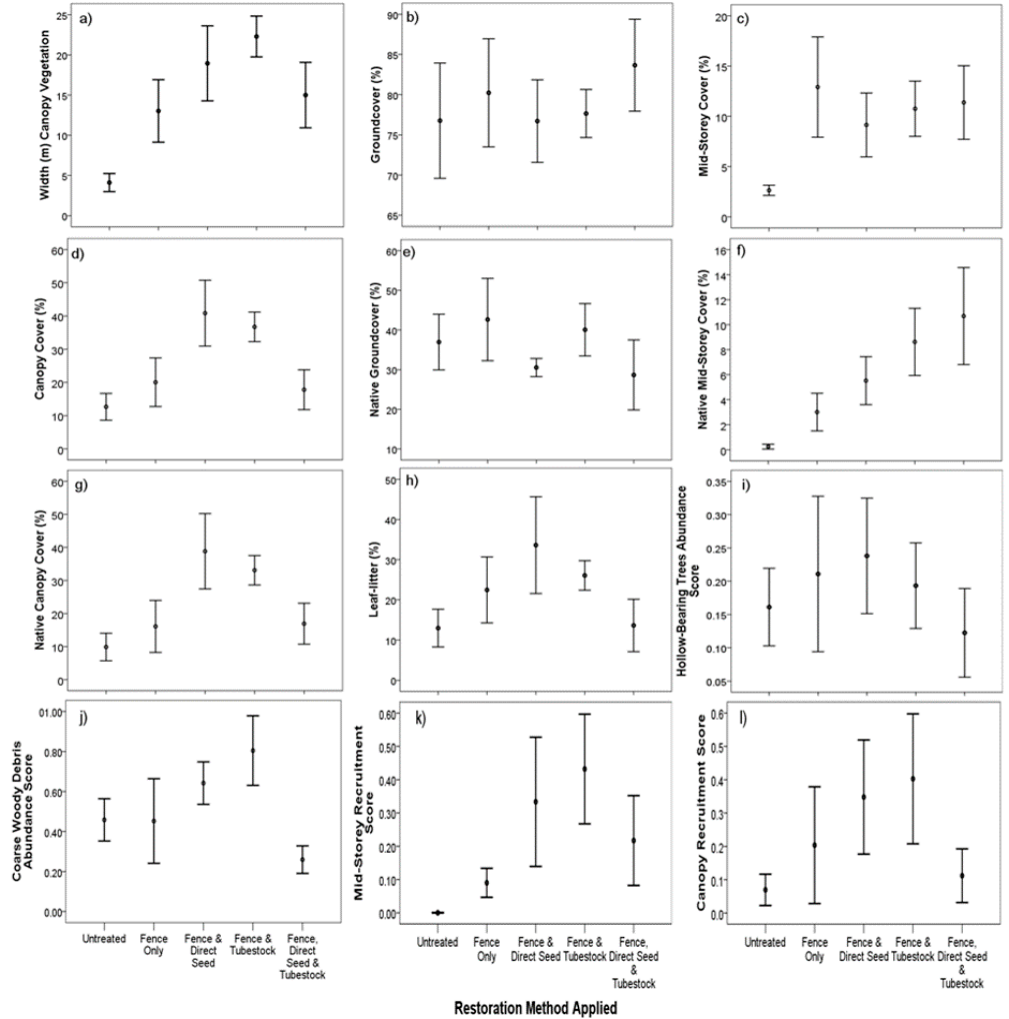
Figure 2. Mean riparian vegetation condition (RARC) scores 10 years after restoration for sites restored as part of the Bidgee Banks Restoration Project (BBRP) using four restoration methods (see Table 1). Untreated site scores are provided as a comparison. Error bars represent ± SE. A heathy site RARC score is 43.